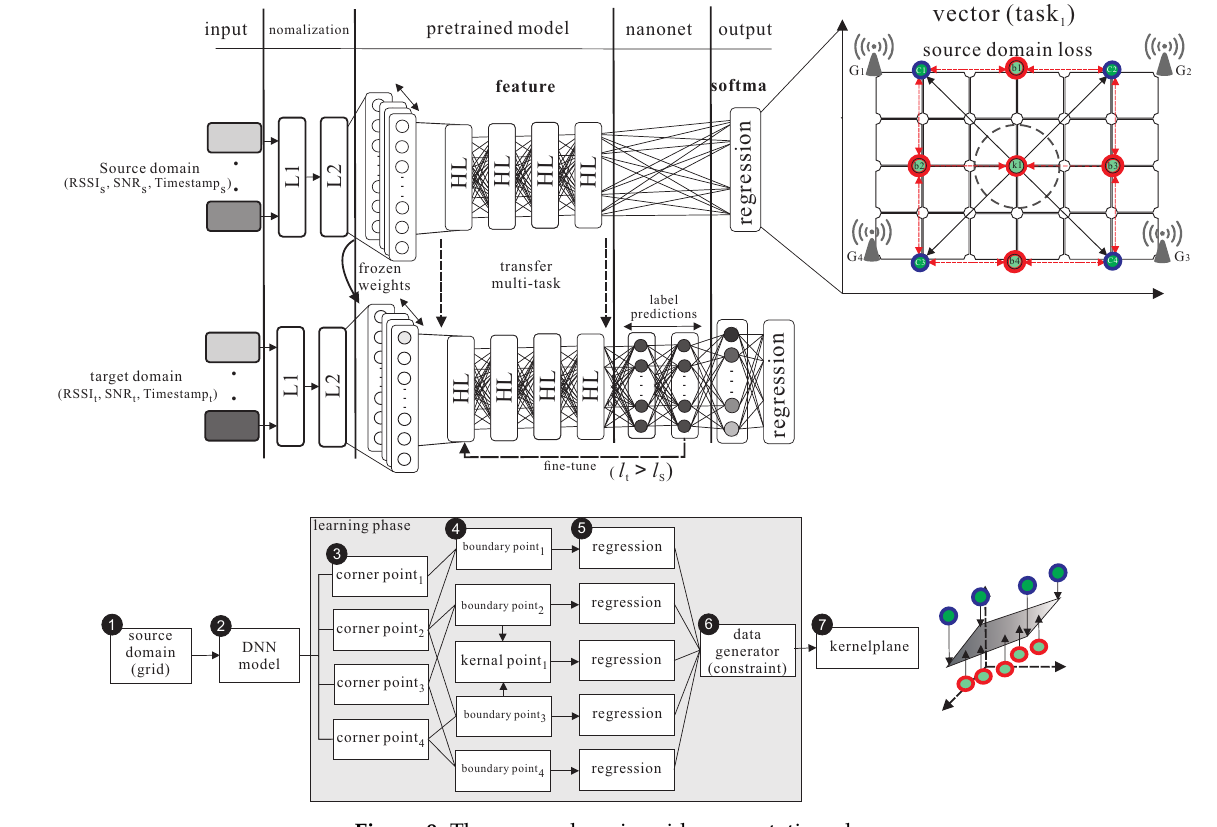
Figure 9. The source domain grid segmentation